Question: Sum up the contents of this chart in one sentence.
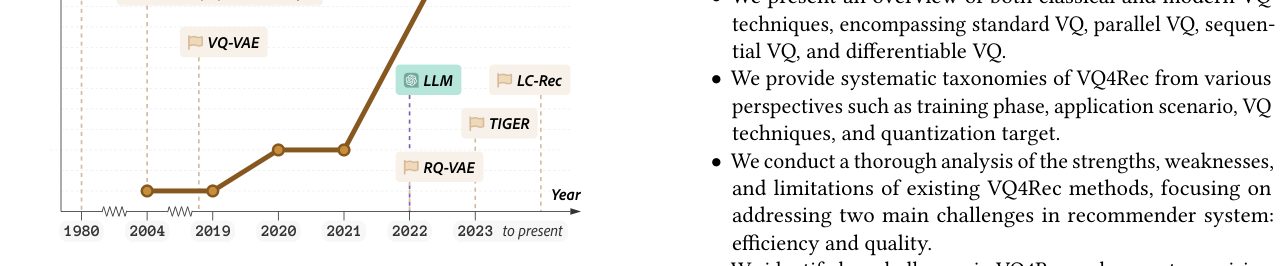
Answer: Interest in VQ4Rec over time. v denotes a milestone event or a representative paper.